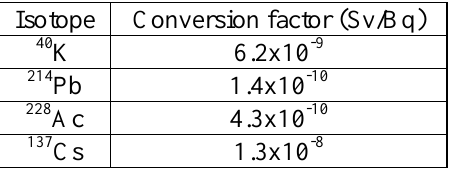
Table 1: The conversion factors of the isotopes found in samples